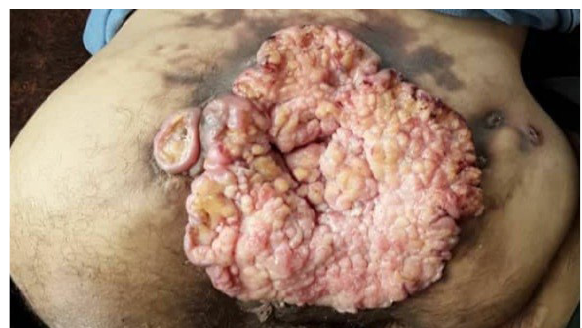
Figure 1. Initial Appearance of the Wound Before Sampling.